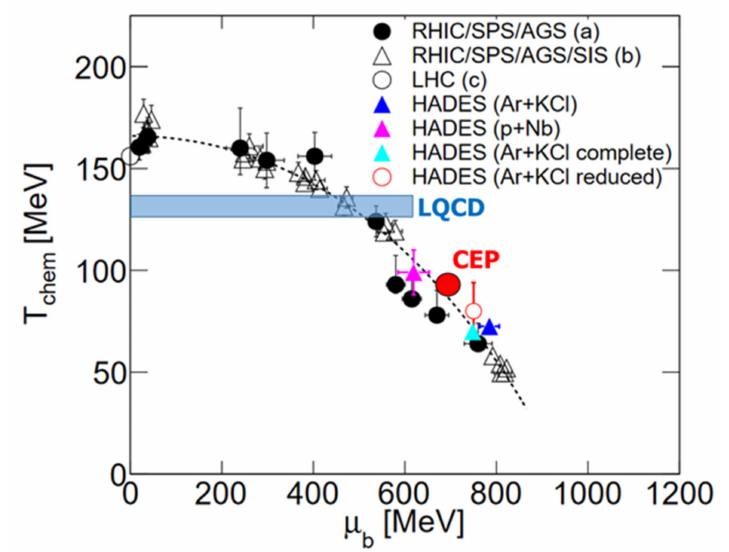
Figure 4. A sketch of the two-dimensional phase diagram of strongly interacting matter in the plane temperature versus baryon chemical potential µ b . The data points are extracted from particle yields measured at different energies using a statistical model [23]. The black dashed line illustrates a freeze-out curvature [24]. The upper limit for the chiral critical point T 0 c = 132 + 3 − 6 MeV predicted by lattice QCD calculations is shown as a blue-shaded area [28]. The critical endpoint CEP predicted by DSE-FRG calculations at T CEP = 93 MeV and µ b = 672 MeV is marked by a full red dot